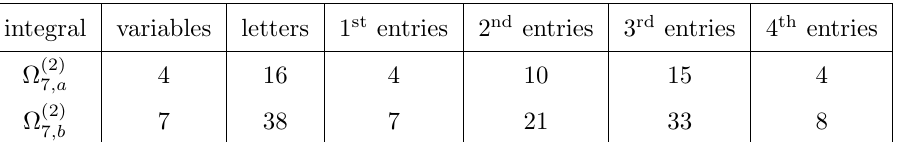
and (cid:10) (2) . We list the 7 ;a 7 ;b